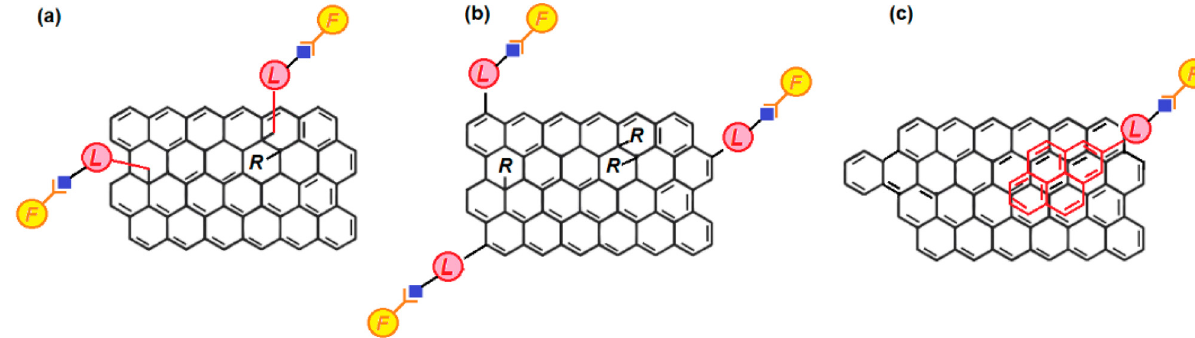
Figure 6: Schematic of the covalent functionalization of graphene via click chemistry in the ( a ) basal plane and ( b ) edges. ( c ) Noncovalent modi fi cation of graphene through π – π stacking interactions of a functionalized pyrene through click chemistry ( L, linker; F, functional group attached through a click approach; R, random graphene substituent; ∟ and ◆ , two complementary chemical parts prone to undergo click coupling ) [ 27 ] .